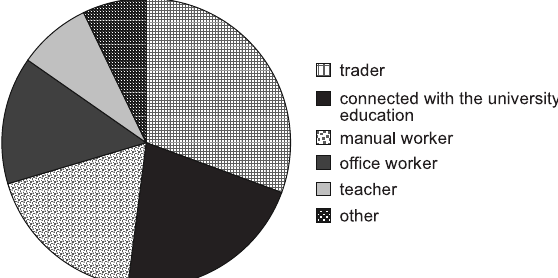
Fig. 3. Share of students of the last year of studies in the structure of